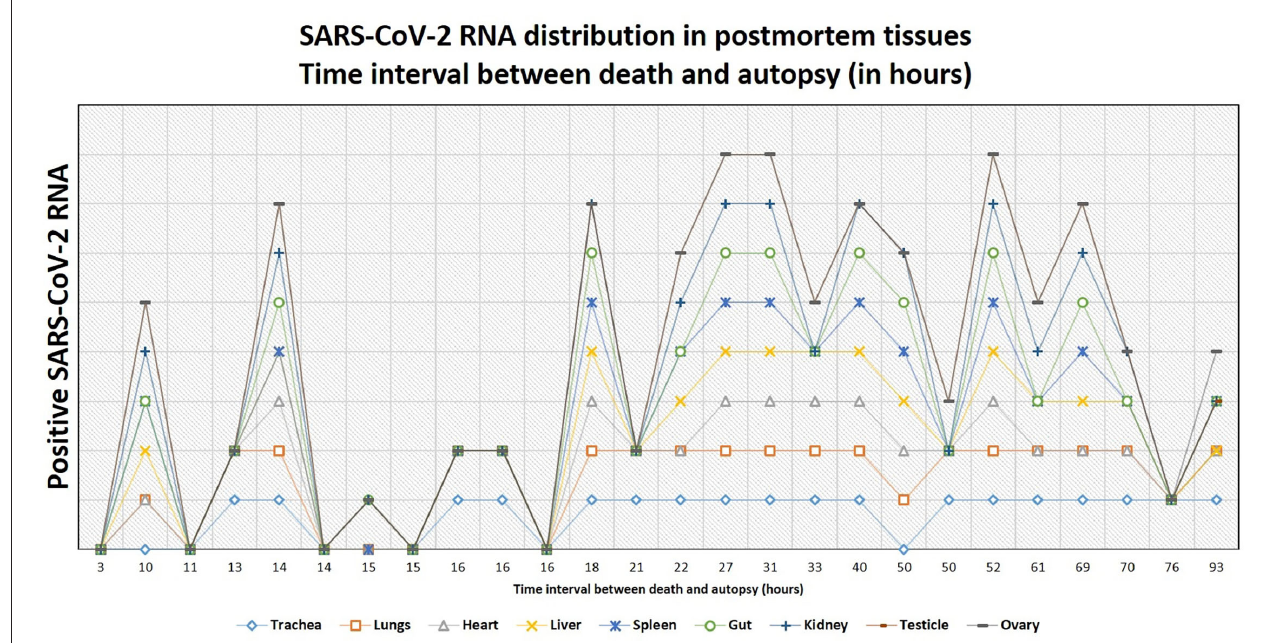
FIGURE 9 | The tendency of postmortem persistence and anatomical distribution of SARS-CoV-2 RNA in relation to the time interval between death and autopsy (postmortem interval, in hours). The lines do not show absolute percentages but only the relative variation in prevalence of the positivity for SARS-CoV-2 RNA. The different levels of the line along the y-axis are chosen to avoid their overlapping and to facilitate the visual interpretation but do not reflect an absolute percentage, for which we refer the reader to the text.